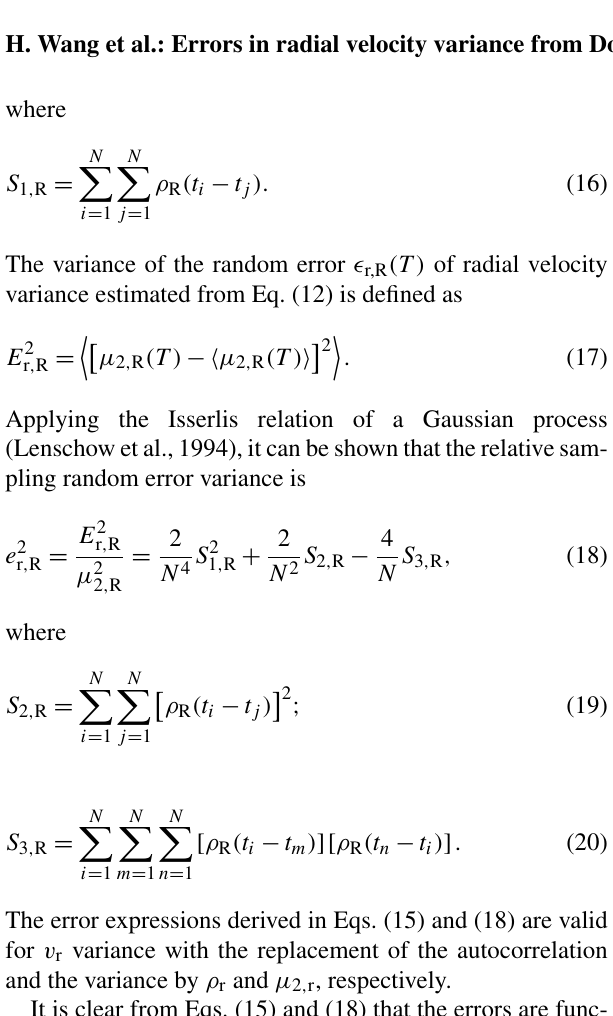
(e.g., τ/τ 0 > 0 . 25), R R = R r because volumetric averaging ence between R R and R r results in ρ R > ρ r for all time with the Kaimal (IECKAI) spectrum model TurbSim (https: //nwtc.nrel.gov/TurbSim) produce similar results. Errors as- sociated with the autocorrelation functions ρ r /ρ R derived from the simulated v r /v R from both models are shown in Fig. 4. Although the difference between the errors of vari- ance of v r and v R varies with LOS orientation and turbulence model (i.e. the turbulence structure), errors associated with v R are consistently higher than those related to v r , indicating that volumetric averaging increases errors associated with ra- dial velocity variance